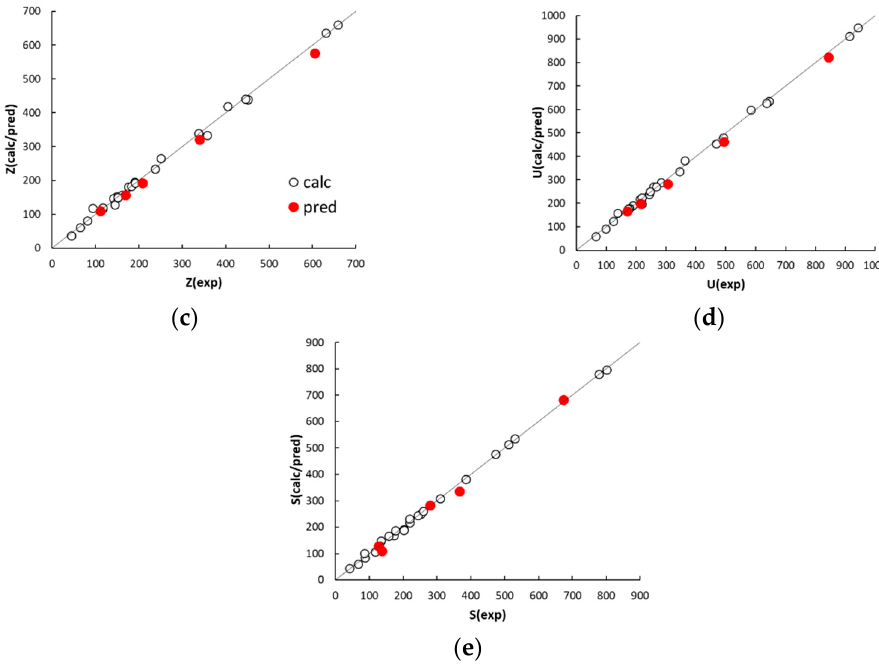
Figure 2. Agreement between experimental McReynolds constants X ( a ), Y ( b ), Z ( c ), U ( d ) and S ( e ), and calculated (white circles) or predicted (red circles) QSRR responses.